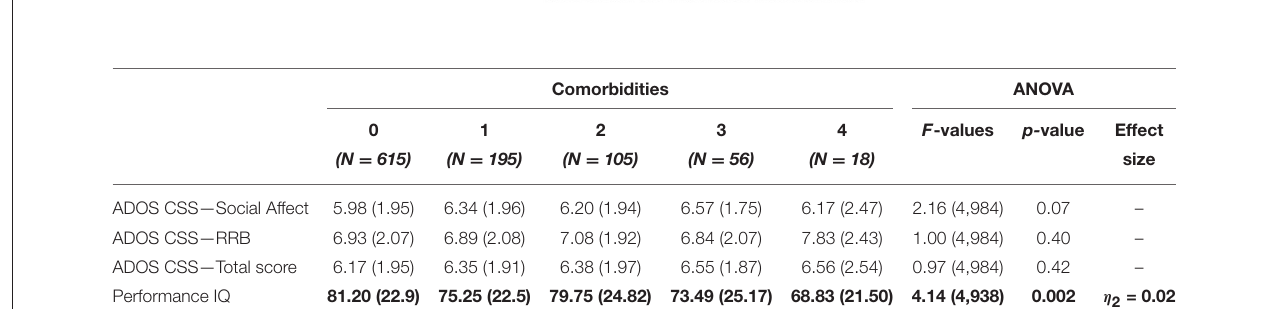
d = 0.17], and CSS–Total scores [ t (987) = 4.22 p < 0.0001, d = 0.27], but no difference as far as prevalence of PC is regarded ( Table 7